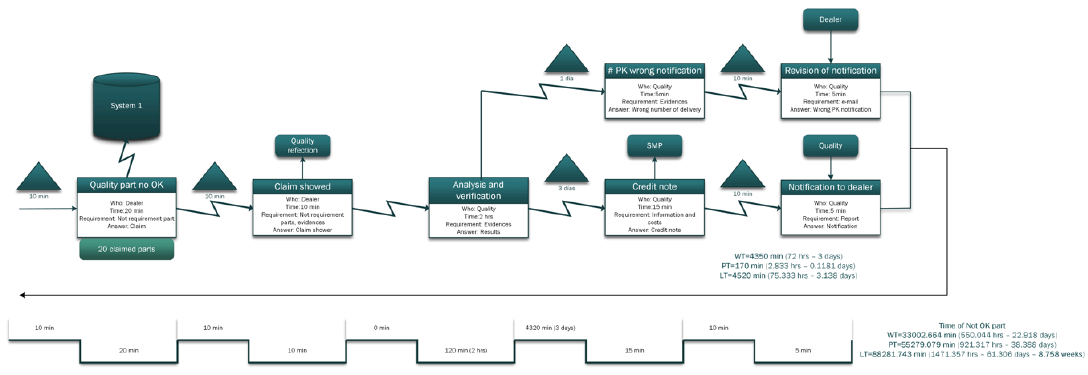
Figure 16. The seventh part of seven of the Current State Value Stream Map with wastes.